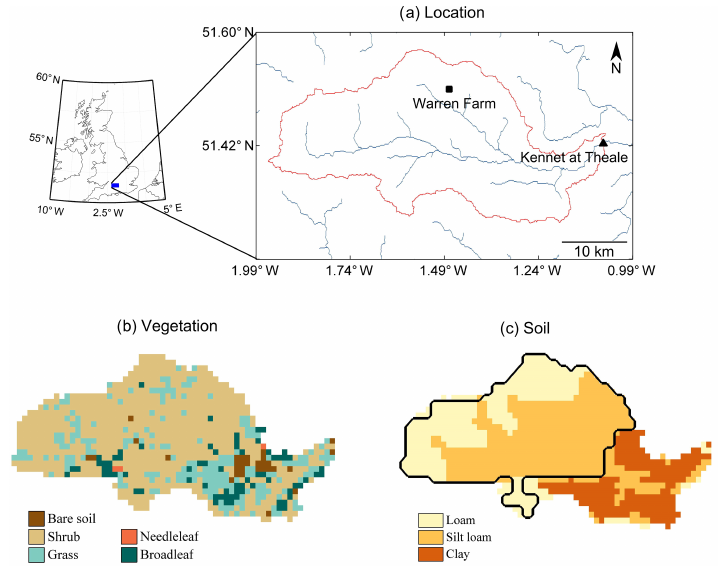
Figure 1. (a) Location, (b) vegetation cover and (c) soil texture over the study area. The red line in (a) outlines the Kennet catchment boundary, while the river network is shown in blue. The black triangle in (a) shows the location of the discharge gauging station at the catchment outlet and the black square corresponds to the Warren Farm location where point-scale simulations are carried out. The black line in (c) encloses the area of the catchment where chalk is